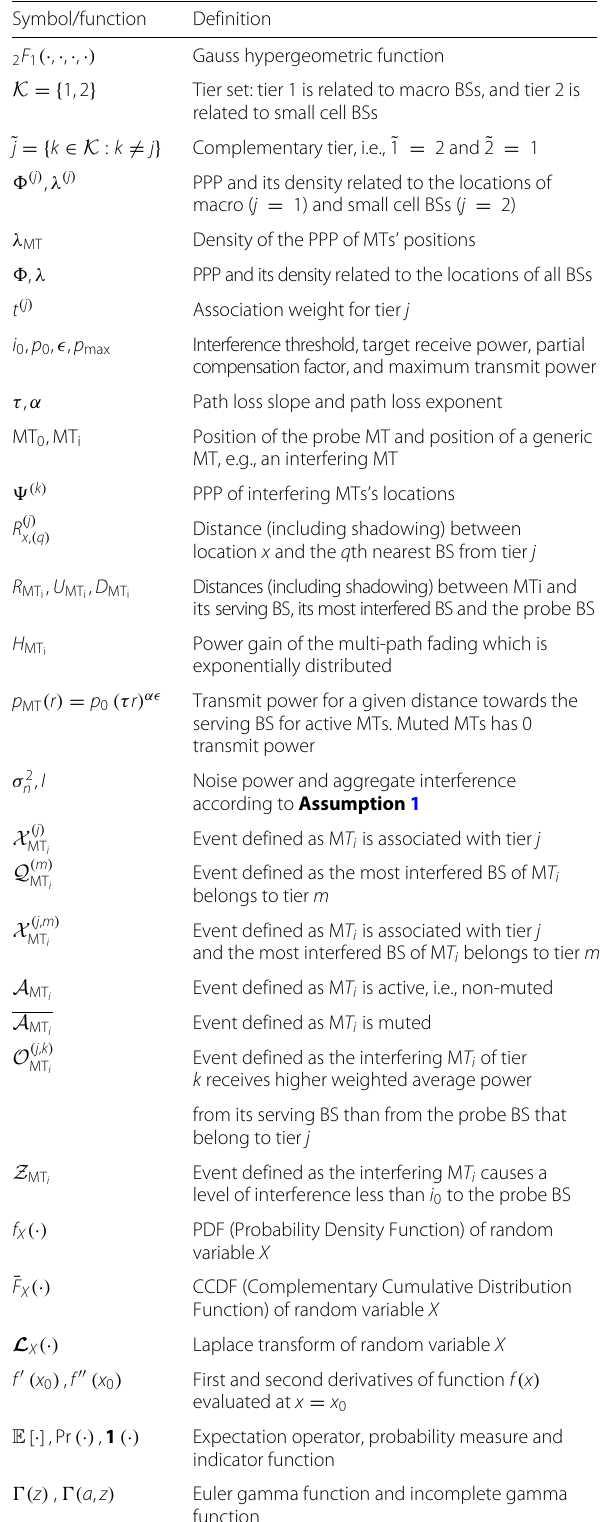
Table 1 Summary of main symbols and functions used throughout the